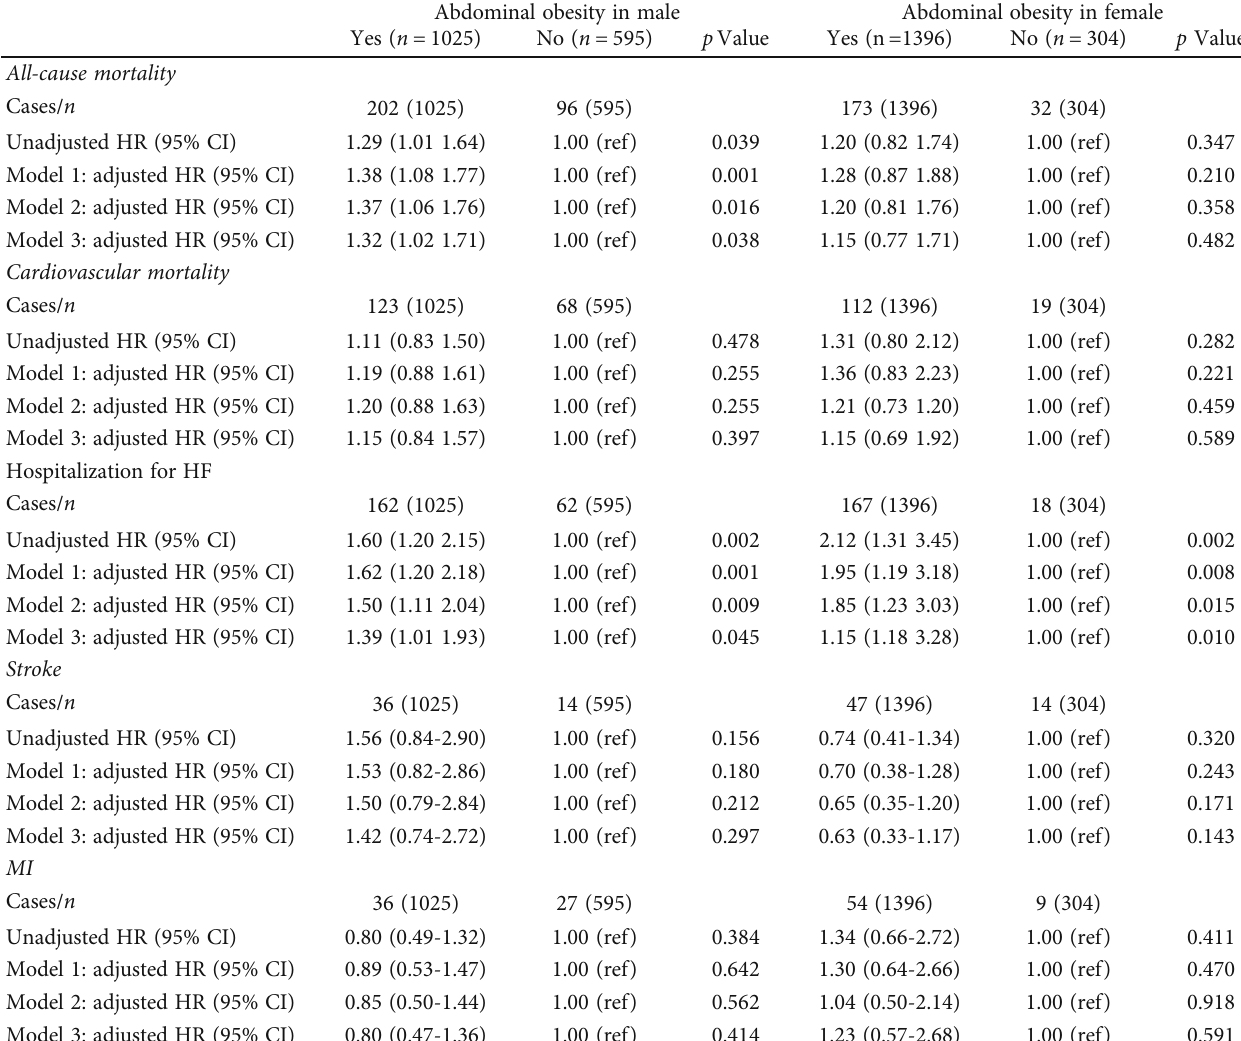
Table 3: The risk of primary and second outcomes in HFpEF patients among